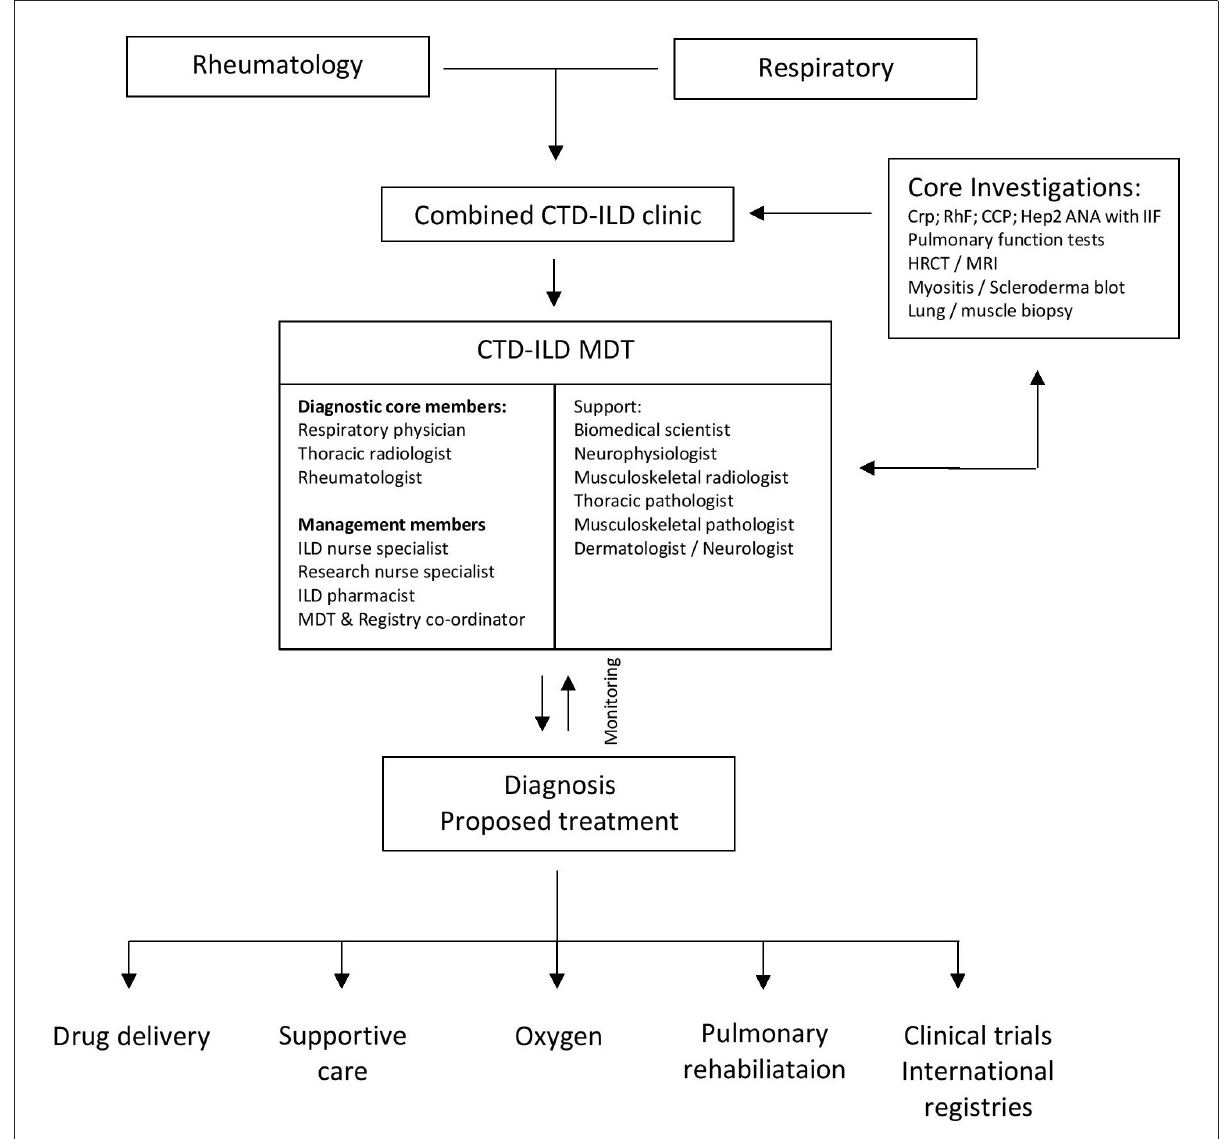
FIGURE6 Multidisciplinary working within the CTD-ILD multidisciplinary